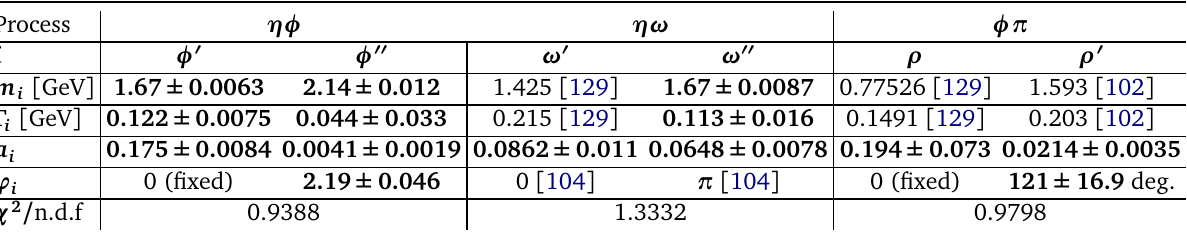
Table 7: Fit values for the ηφ , ηω , and φπ channels.